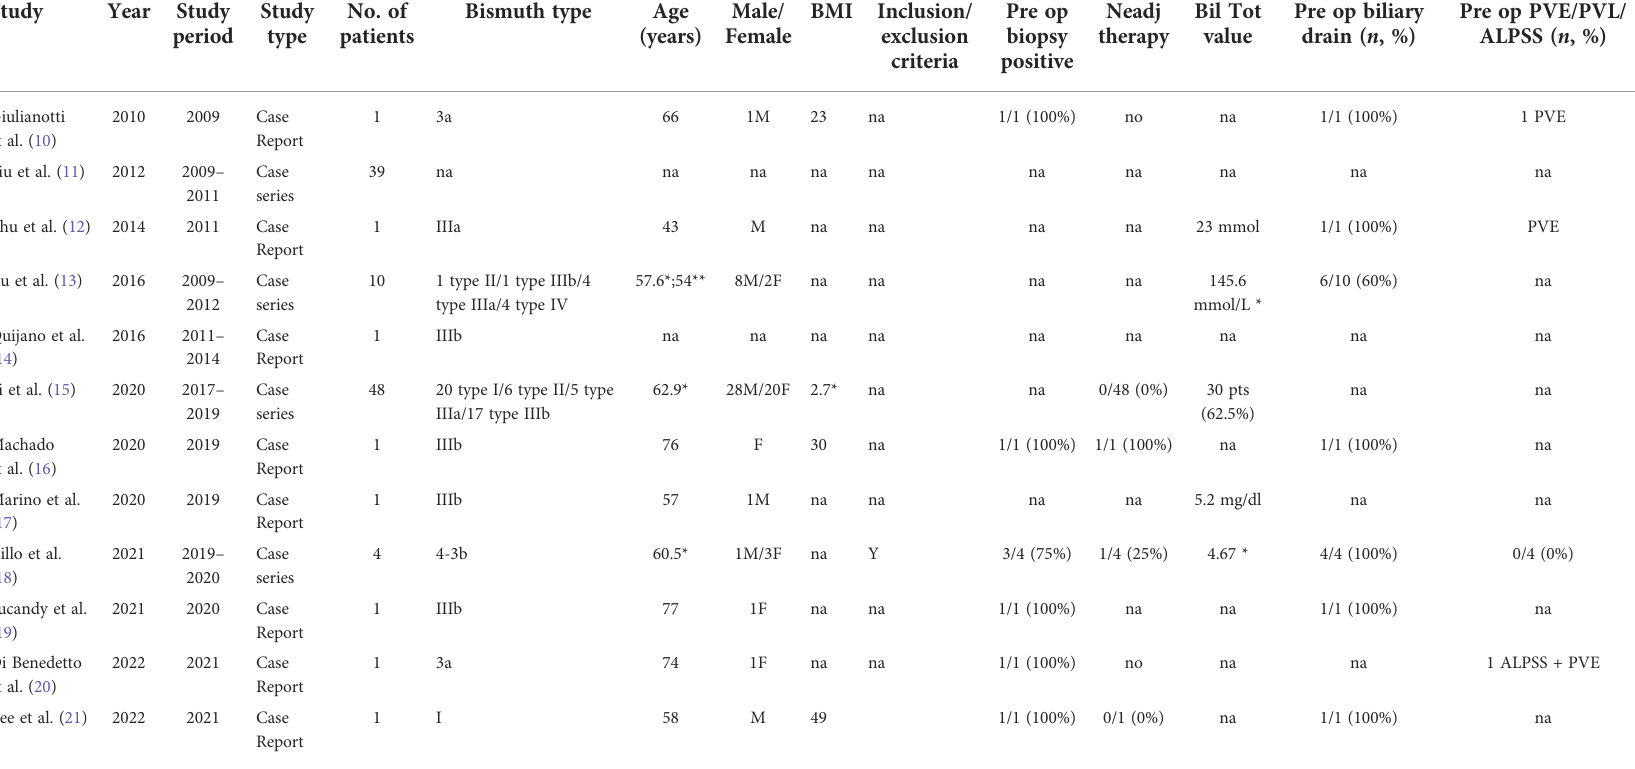
ALPSS, associating liver partition andportal veinligation for staged hepatectomy; BMI ,body massindex; F,female; HC ,hilar cholangiocarcinoma; M ,male; na,not available; PVE, portalvein embolization; PVL,portal vein ligation;* , mean;** ,median. na, not applicable.